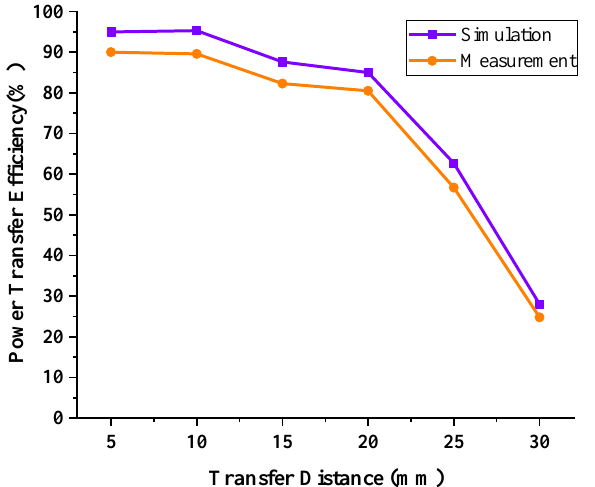
Figure 15. Simulated and measured PTEs of the WPT link with four-turn split-ring loops at different transfer distances.